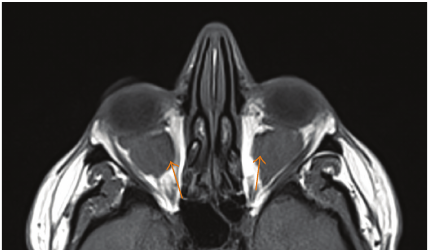
Figure 6: A 35-year-old male with unenhanced axial T1 image showing bulky, homogeneously hypointense soft tissue lesions (arrows) in the intra- and extraconal retrobulbar space.